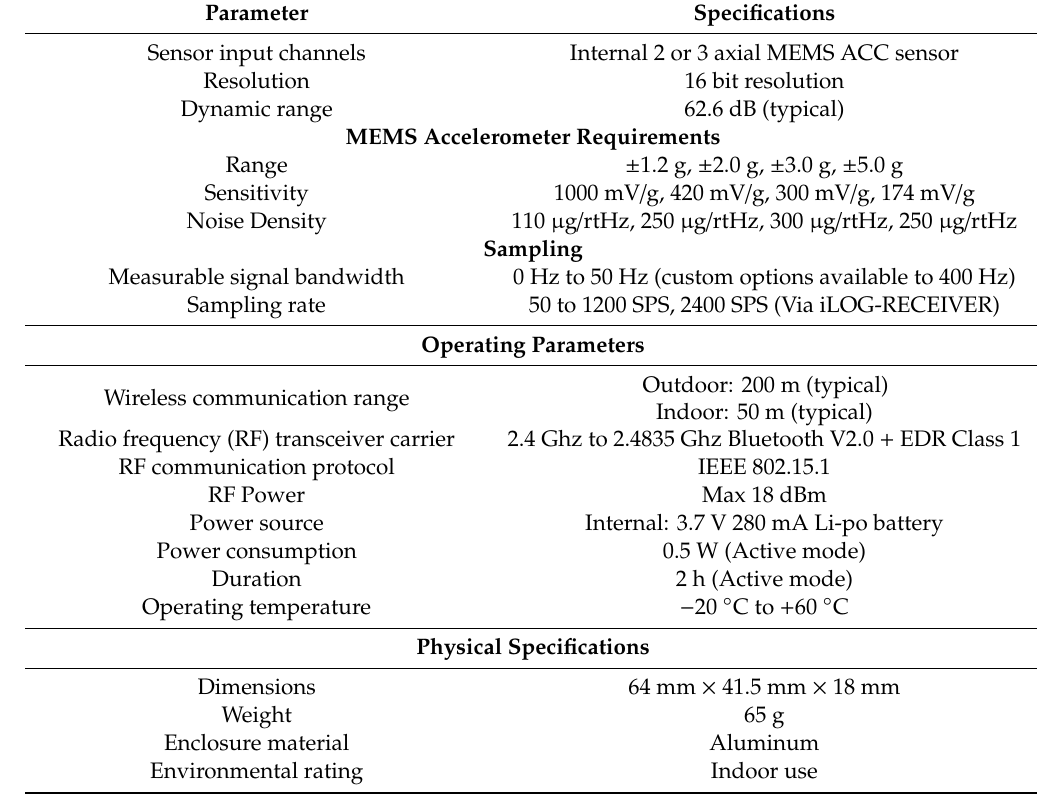
Figure 3. Pictures of ( a ) high-speed camera; ( b ) target. Table 1. Detailed specification of acceleration (iLOG-MEMS-ACC) used in shaking table test.